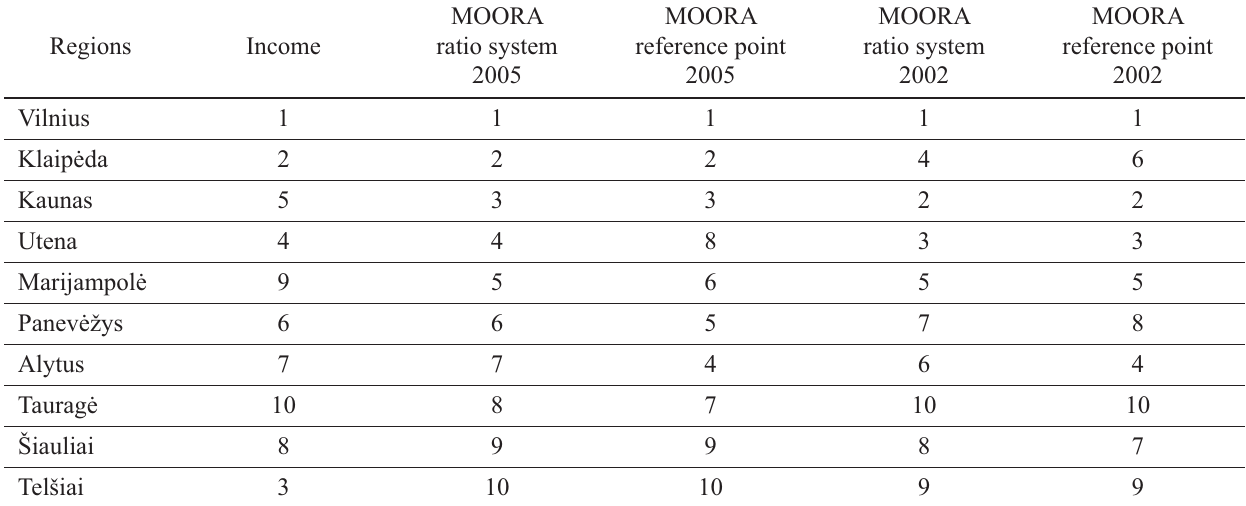
Table 4. Ranking of the Lithuanian Regions according to their well-being importance